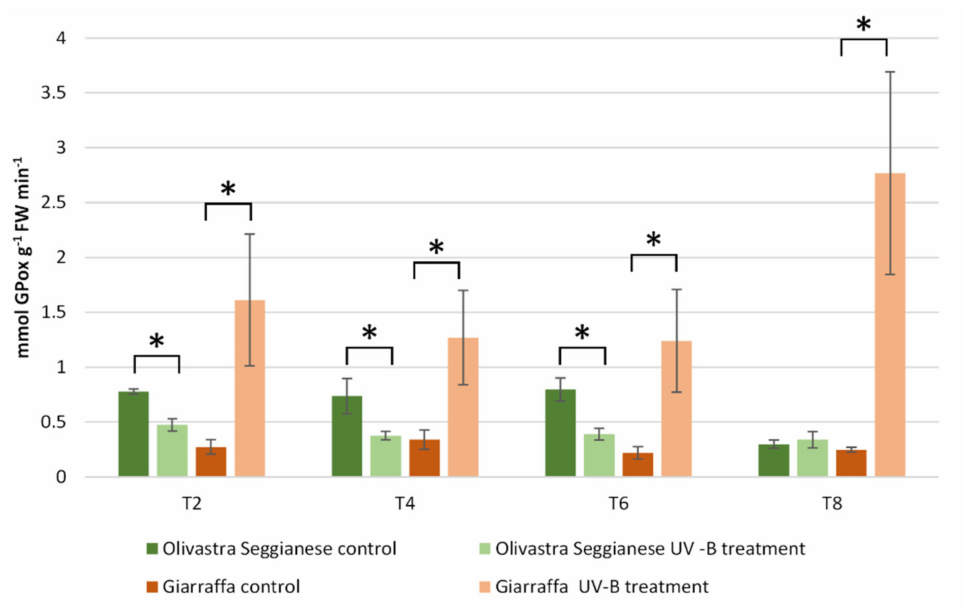
Figure 4. Glutathione peroxidase activity in Giarraffa and Olivastra Seggianese leaves under control conditions and after exposure to UV-B treatment. The X -axis indicates the treatment times. Asterisks (*) indicate statistically significant differences between control and stressed samples within each variety. The two varieties differ by ANOVA test for p ≤ 0.01. Values are mean ± standard ( n =